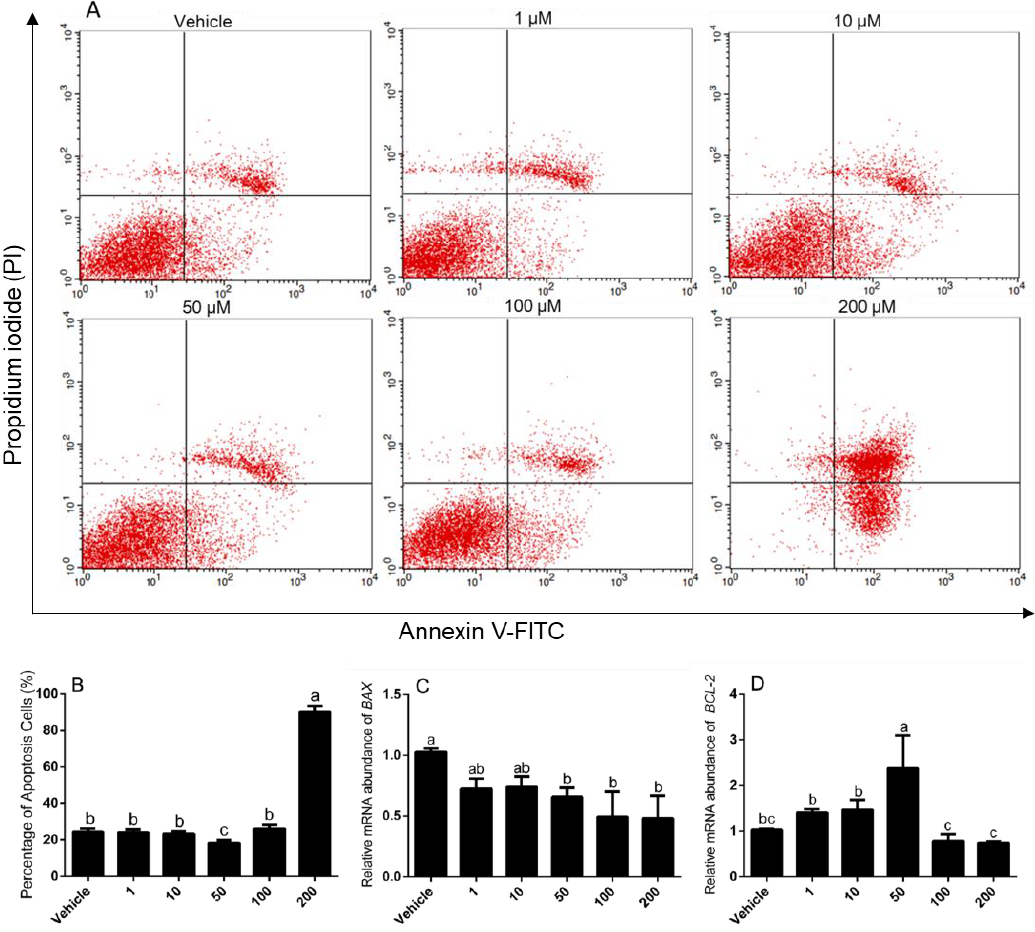
Figure 2. E ff ects of AA on the apoptosis in granulosa cells. Cells were challenged with increasing doses of AA for 24 h starting on Day 3 of culture. ( A ) The apoptotic cells were detected by flow cytometry. ( B ) Quantitative result of cells apoptosis as shown in A, ** p < 0.01. Abundance of mRNA encoding BAX ( C ) and BCL-2 ( D ), * p < 0.05. Data are means ± SEM of three independent replicates. For each treatment, means without common letters are significantly di ff erent ( p <